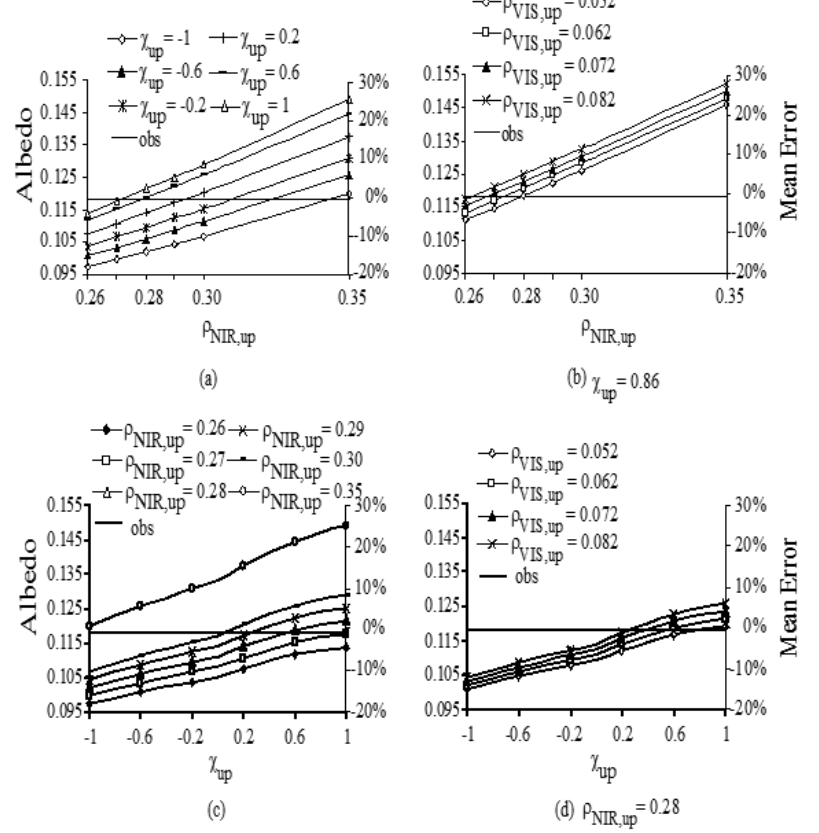
Fig. 4 – Sensitivity analysis of the simulated albedo and its mean error as a function of a) ρ NIR , up and χ up , b) ρ NIR , up and ρ VIS , up , setting χ up = 0 . 86, c) χ up and ρ NIR , up , and d) χ up and ρ VIS , up , setting ρ NIR , up = 0 . 28, for the Cuieiras Biological Reserve